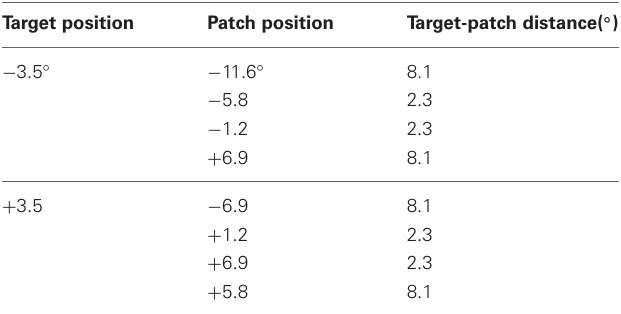
Table 1 | Experiment 4: possible positions of target and patch. Target position